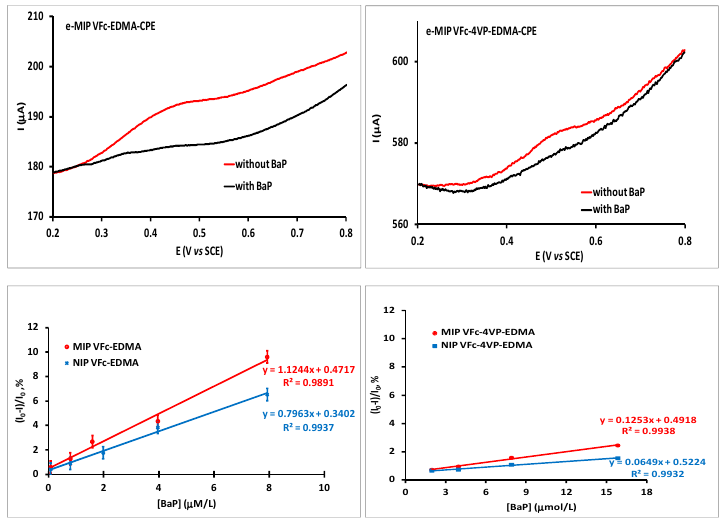
Figure 3. Top: SWV of e-MIP VFc-EDMA-CPE and e-MIP VFc-4VP-EDMA-CPE with and without BaP (1 mg/L) after 4 h. Down: normalized current curves where I was the current obtained in presence of BaP and I 0 the current before BaP addition.